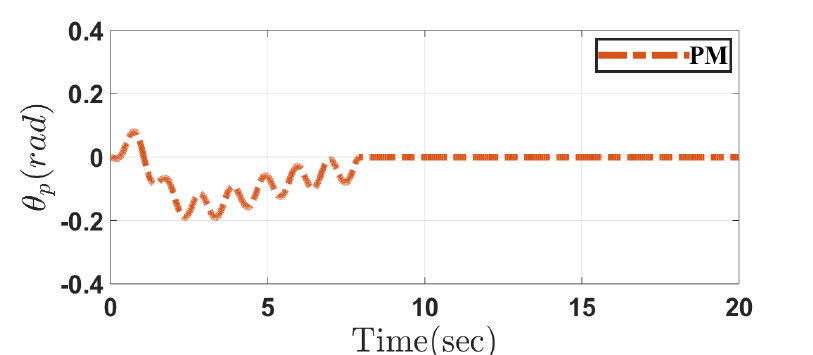
Figure 11. Movable mechanism angle in the proposed method (PM) in Case 1.